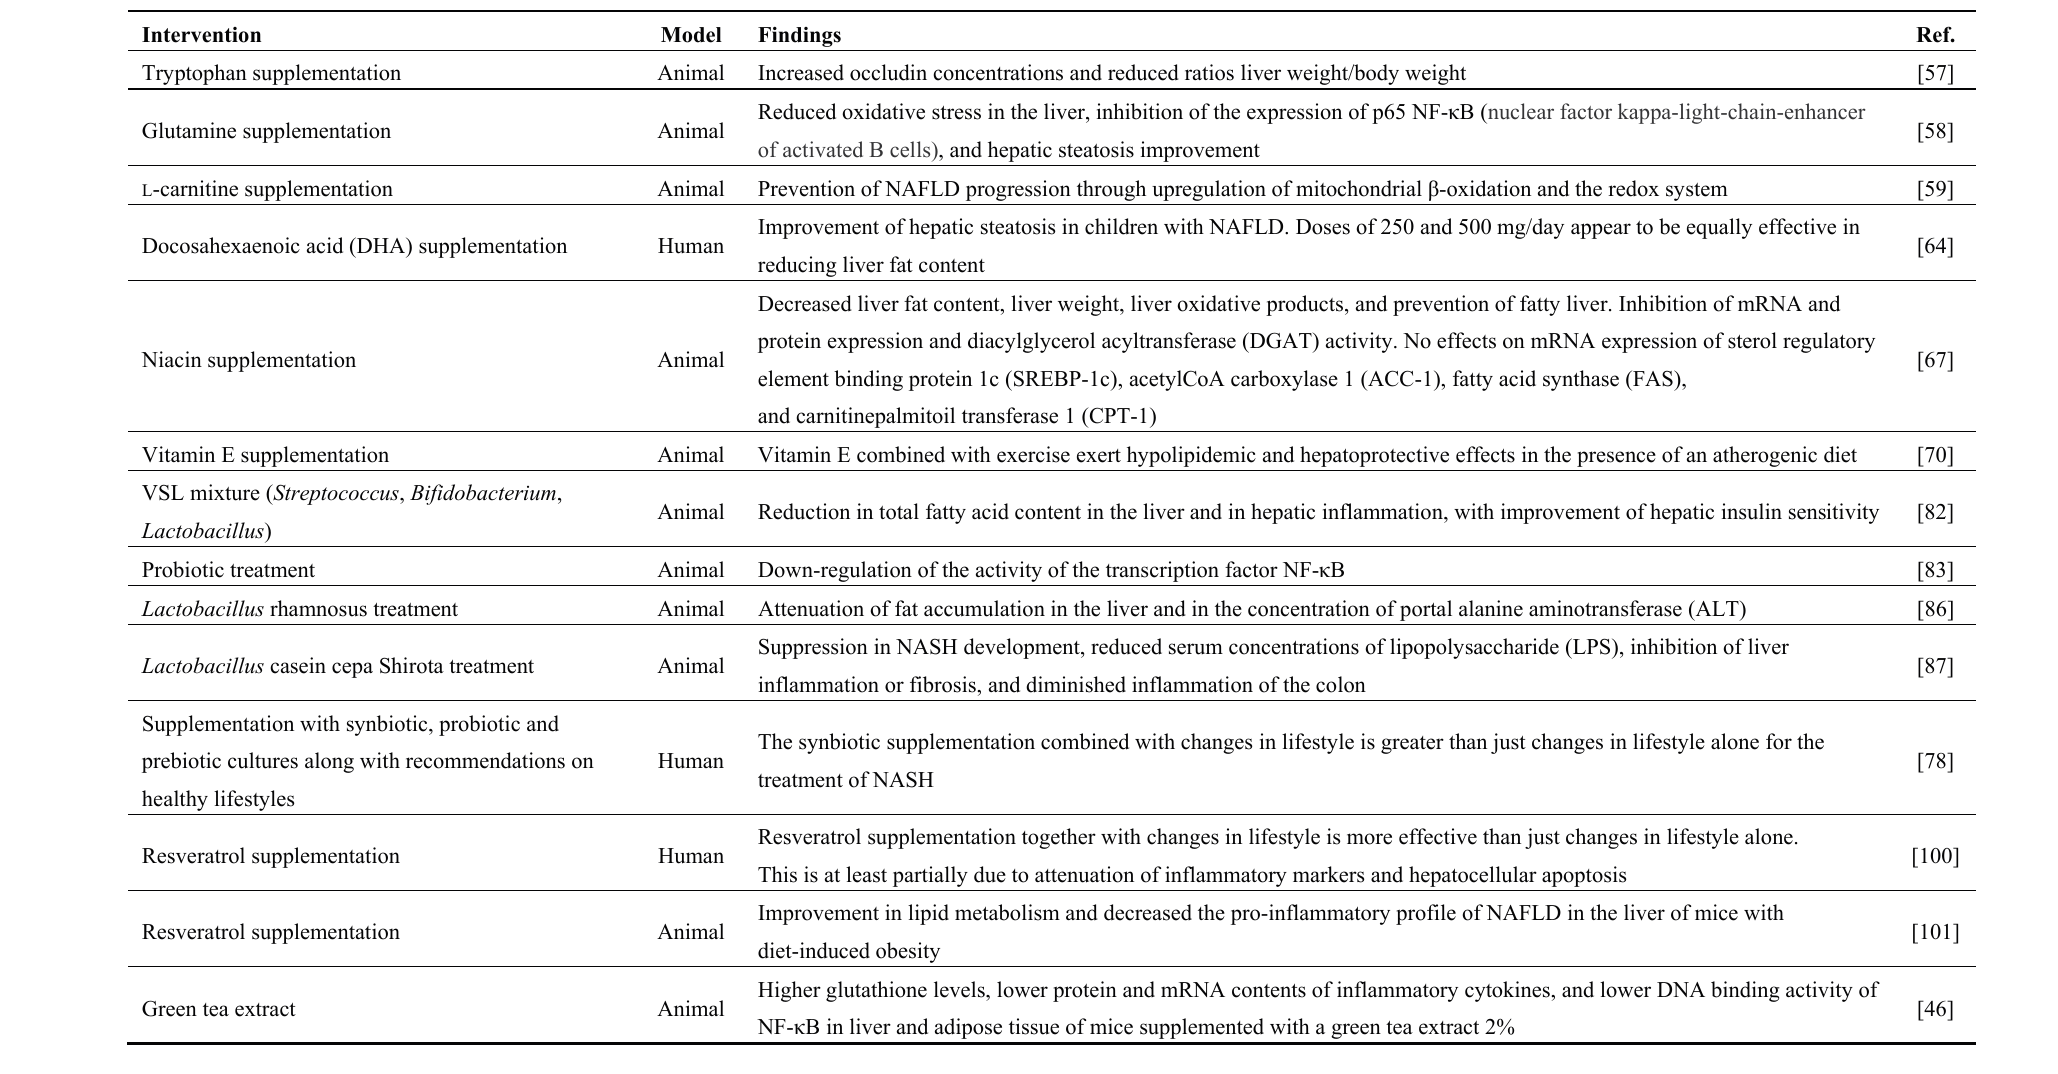
Table 3. Studies on therapeutic agents used in non-alcoholic fatty liver disease